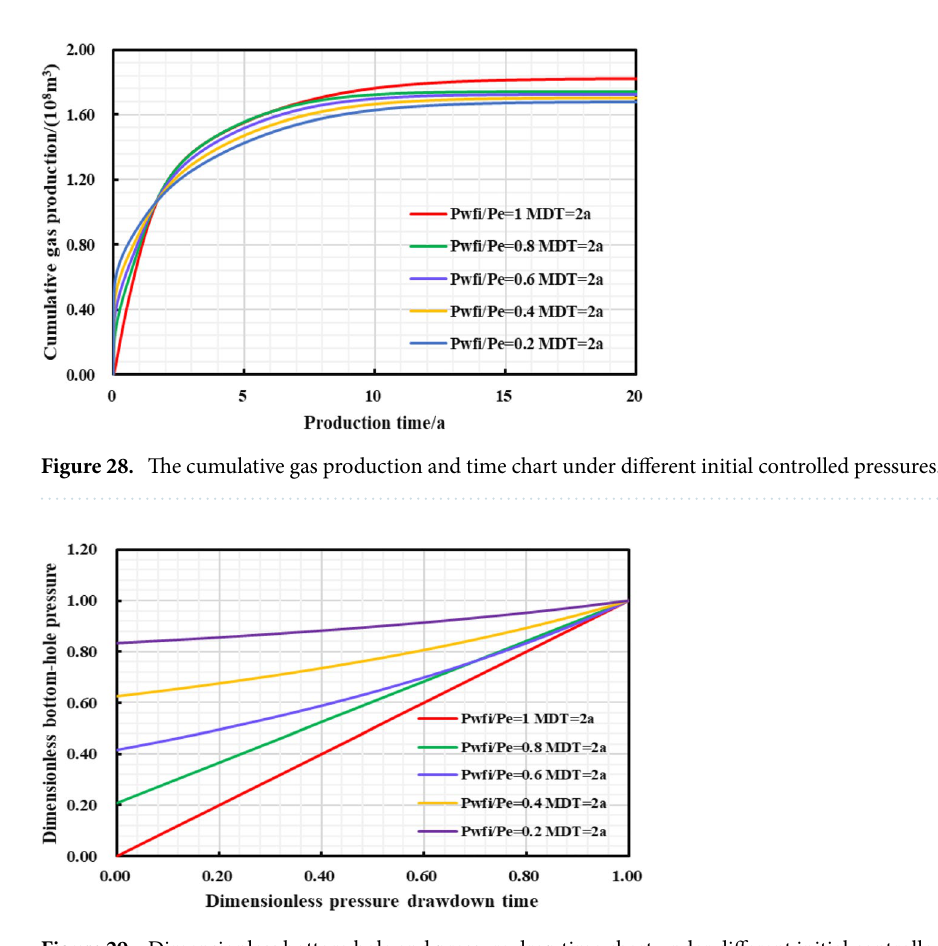
Figure 29. Dimensionless bottom hole and pressure drop time chart under different initial controlled